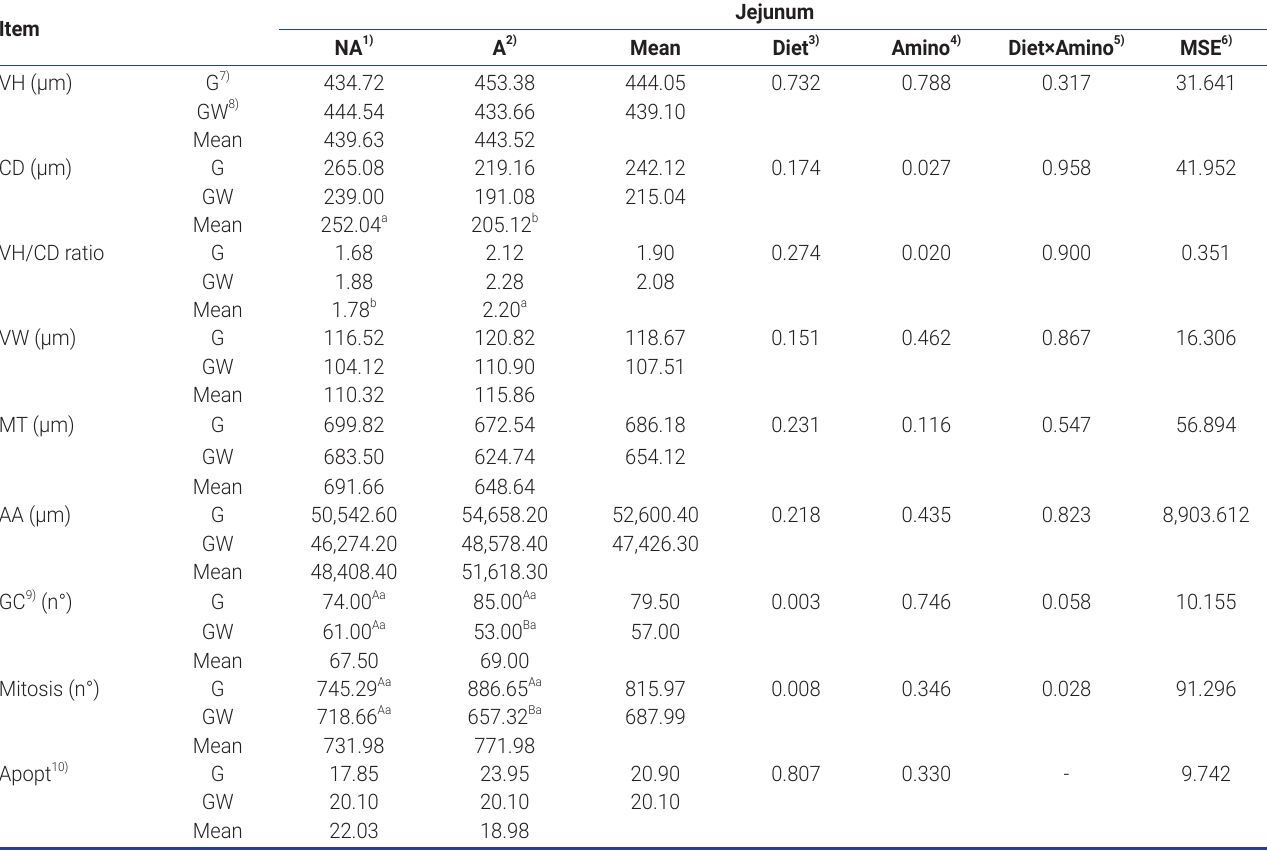
Table 4. Intestinal morphometry, mitosis rate and apopitosis in the jejunum epithelium of piglets fed diets supplemented with L-glutamine + L-glu- tamic acid in diets with or without whey powder